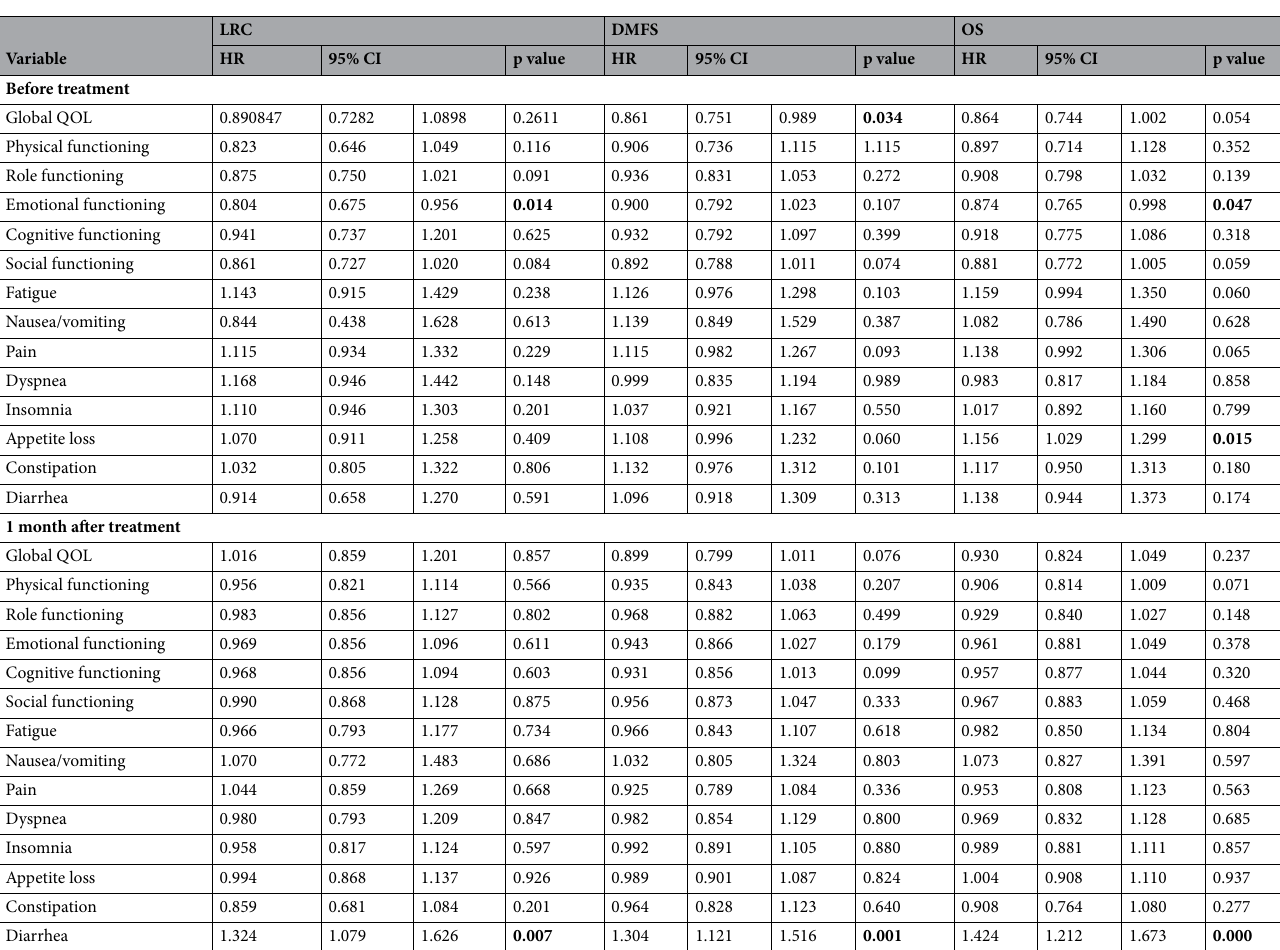
Table 3. Multivariate analysis QOL scores for LRC, DMFS, and OS. Each QOL variable was analyzed separtely in the model, adjusting for clinical stage, PS, tumor location, and smoking index. HR measures correspond to 10-point increments in QLQ-C30 scores. Abbreviations are the same as in Table 2. Significant values are in